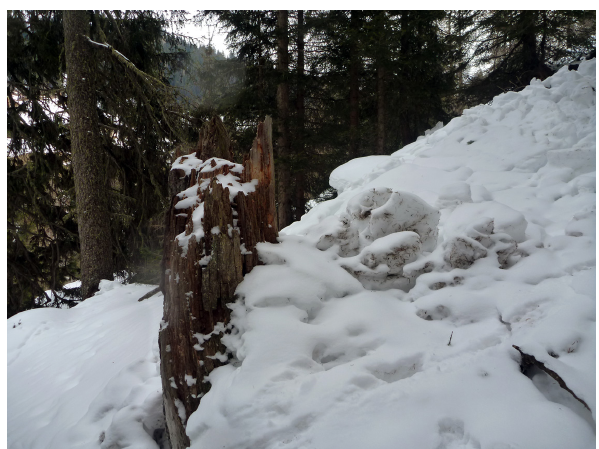
Figure 8. Snow detrained by a stump, highlighting the significant effect of surface cover on small-scale avalanches which should be considered in avalanche